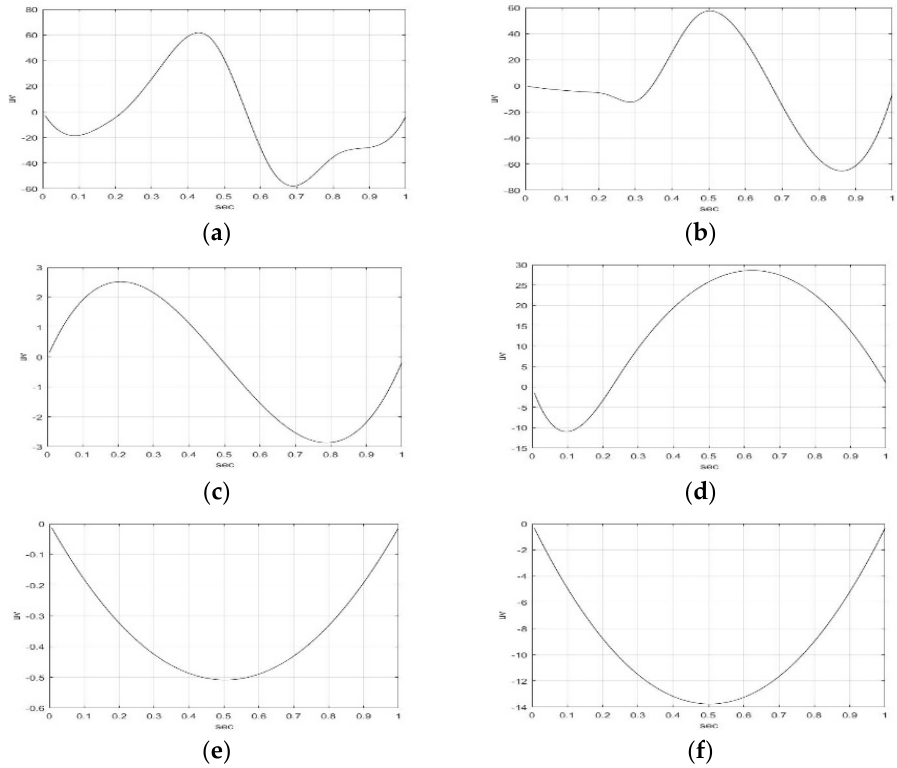
Figure 4. IMF4-IMF5, and RF of F5AM and F5MI sample 1 EEG signals, respectively. ( a ) F5AM IMF4, ( b ) F5MI IMF4, ( c ) F5AM IMF5, ( d ) F5MI IMF5, ( e ) F5AM RF, and ( f ) F5MI RF.